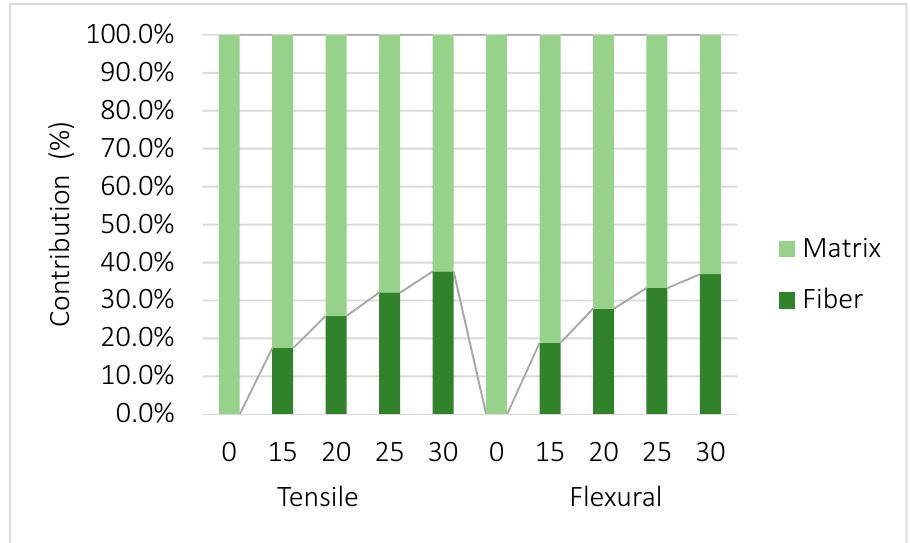
Figure 7. Contributions of the matrix and the reinforcements to the tensile ( left ) and flexural ( right ) strengths of the composites at different fiber content percentages (x axis).